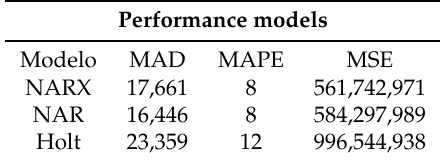
Table 4. Comparative